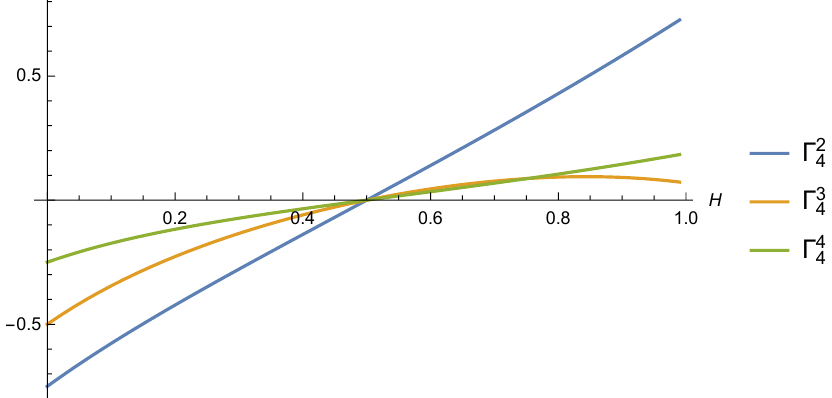
Figure 10. Case n = 4: Γ 2